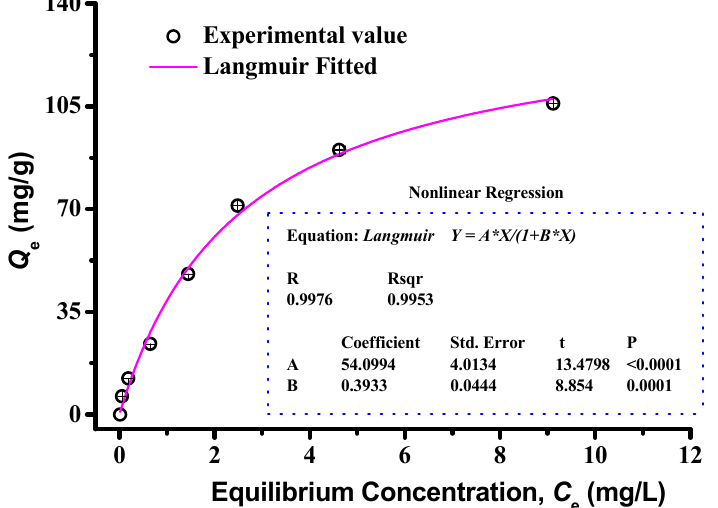
Figure 1. Langmuir isotherm for Cu 2 + adsorption on 500 mg L − 1 of GO at pH 5.0 and 1 mM